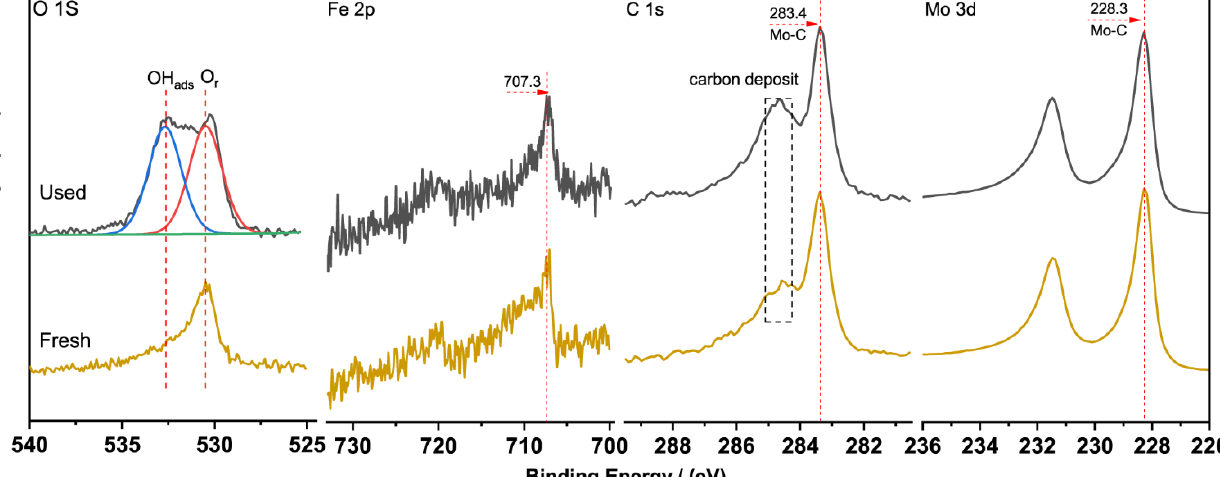
Figure 8. XPS spectra of fresh and spent catalysts of 1.5Fe-Mo 2 C-550 to study the change due to the reaction.